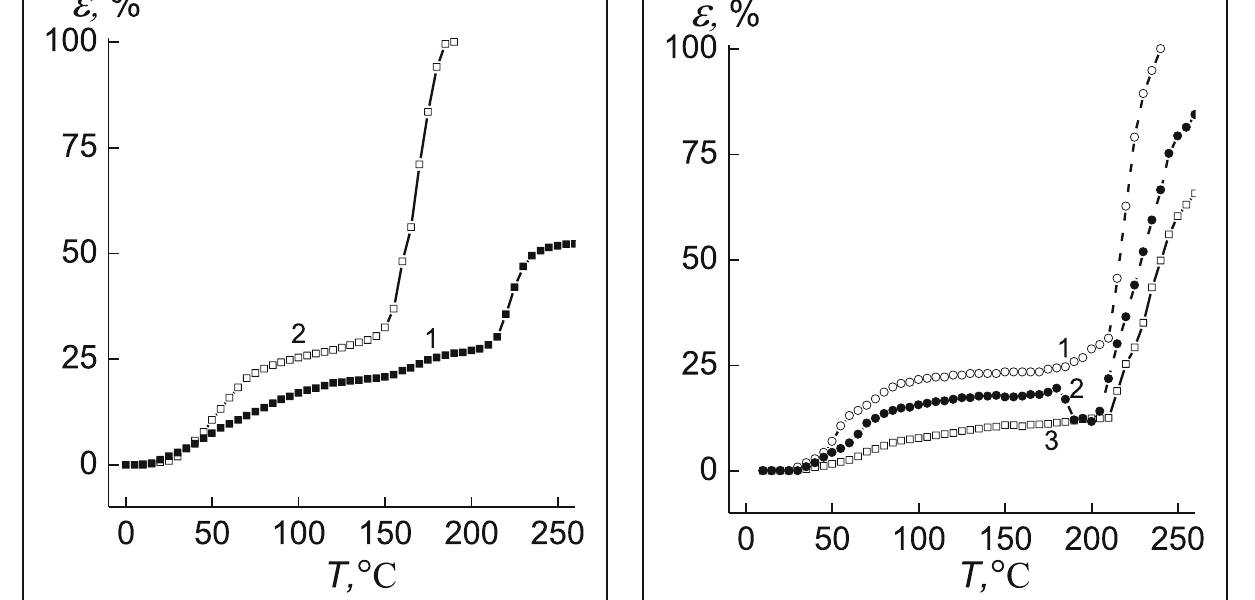
Fig. 5 Thermomechanical curves of 1 the IPEC pectin – P4VP, 2 the IMC pectin – Ag + – P4VP, and 3 the IPEC – Ag 0